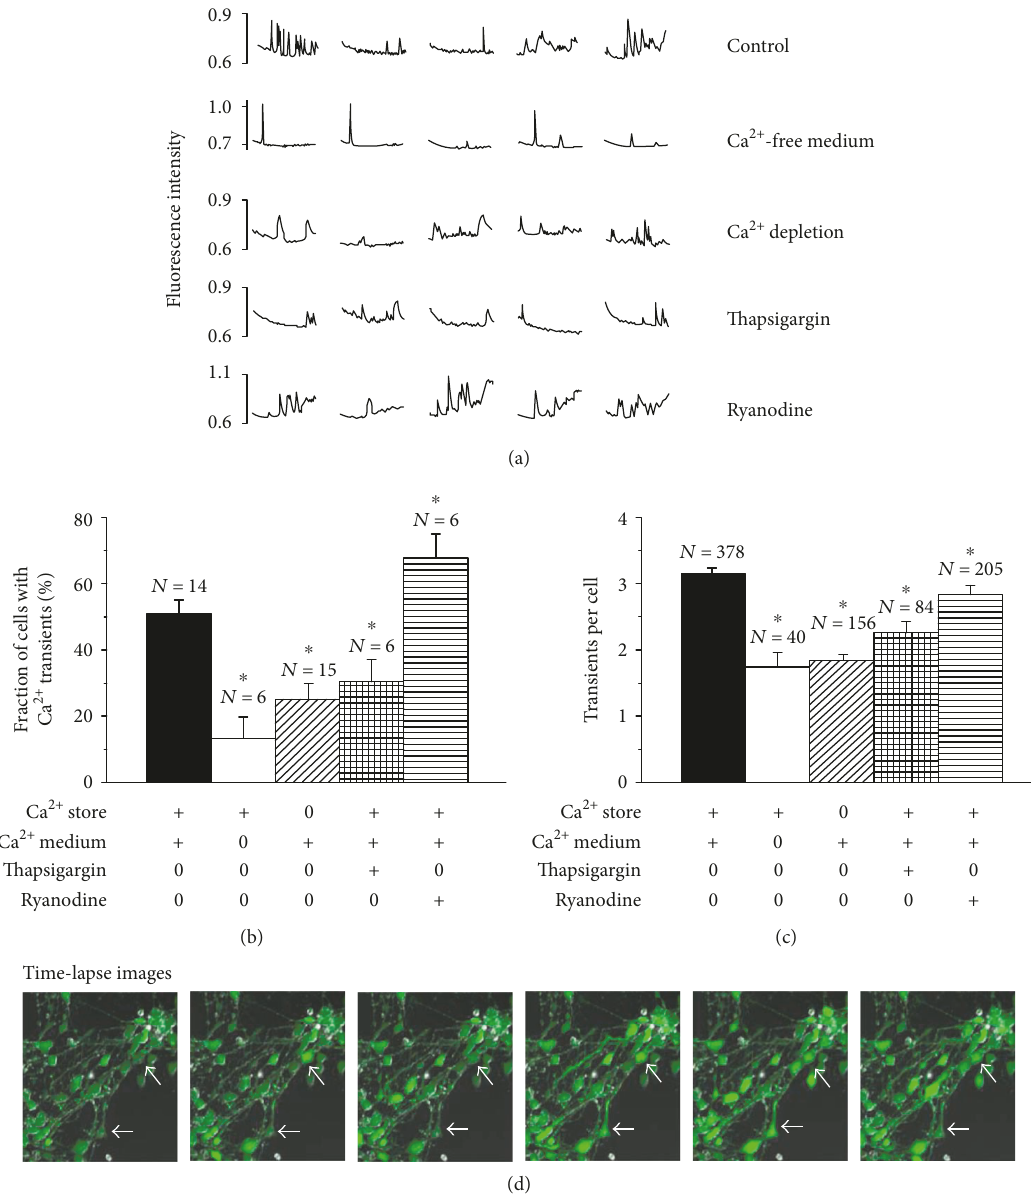
Figure 2: Spontaneous calcium transients in cytosol of di ff erentiating stem cells are dependent on intracellular and extracellular calcium supply. Fura-2-loaded cells were measured for 20min at room temperature. The pattern of calcium transients from fi ve representative cells is shown (a). The fraction of cells with calcium transients (cytosolic calcium increase followed by decrease) was calculated in each experiment (b), as was the number of transients per cell (c). The cells were incubated in the presence or absence of extracellular calcium as indicated on the fi gure. Pretreatment with thapsigargin in the absence of calcium was used to deplete the intracellular calcium stores (third bars in the two histograms). Ryanodine was used to study the role of ryanodine receptors. The mean values and SEM from 6 – 15 independent experiments (b) and 40 – 378 cells (c) are shown. ∗ indicate signi fi cant di ff erence from the control value. Consecutive recordings (still images) of Fluo-4-loaded cells with a 60 sec interval ((d); corresponding video available, see Supplemental Figure 1